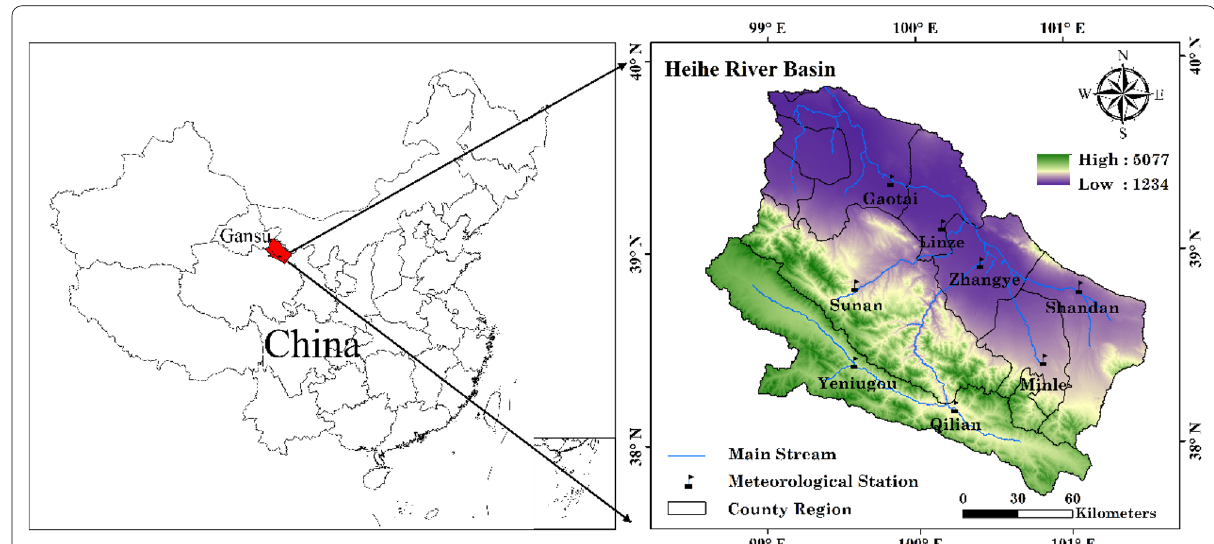
Fig. 1 Location of the upper and middle reaches of the Heihe River basin, the river network, DEM, meteorological stations, and the main counties in the study area